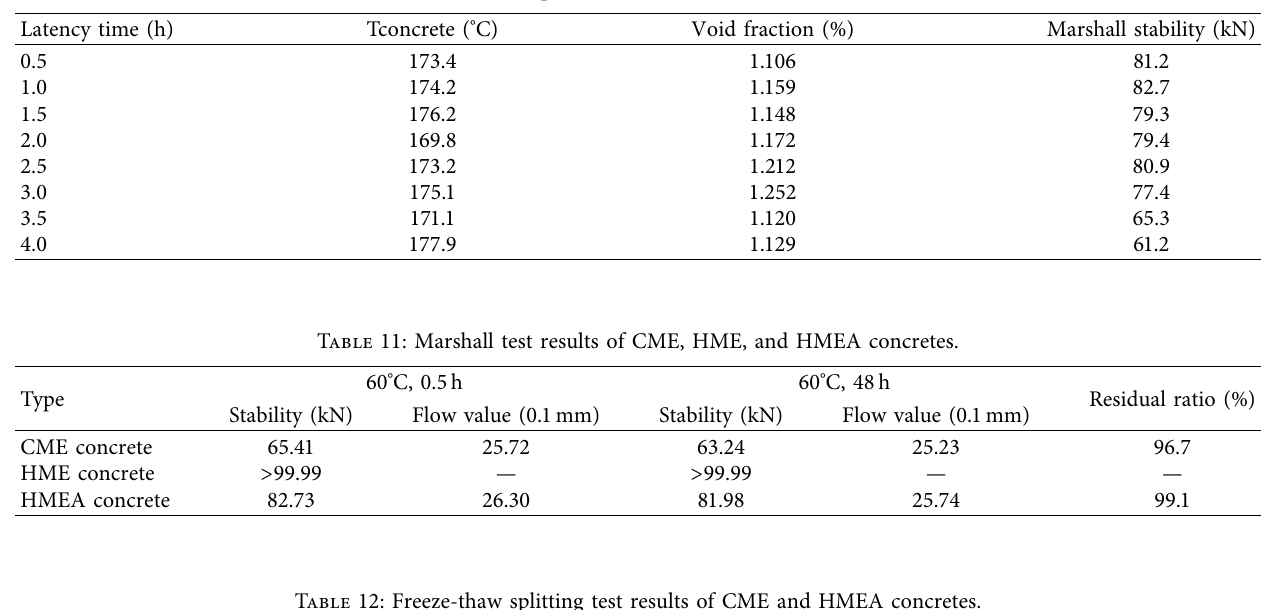
Table 10: Workable performance of HMEA concrete at 170 ° C.